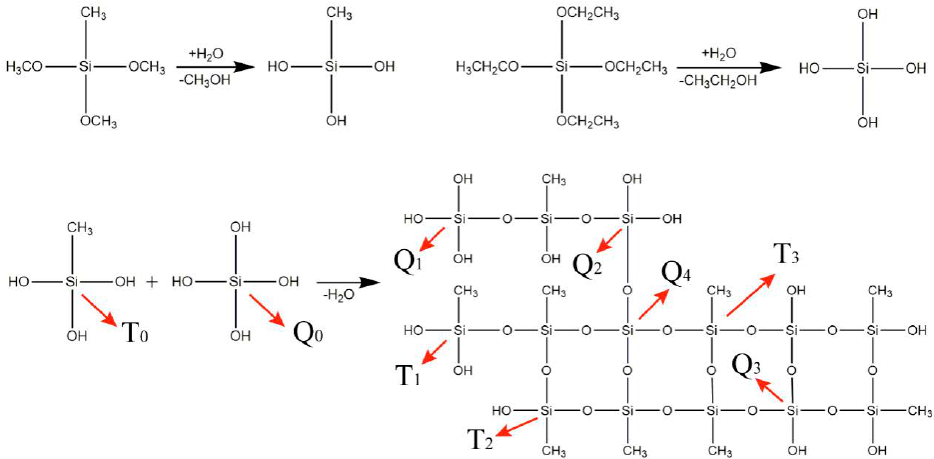
Scheme 1. The hydrolysis and condensation reactions of TEOS and MTMS.